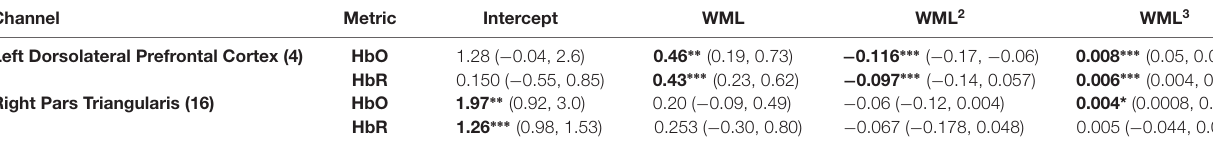
TABLE 2 | Effects of working memory load on relative concentrations of HbO frontal cortex for the most parsimonious models. Channel